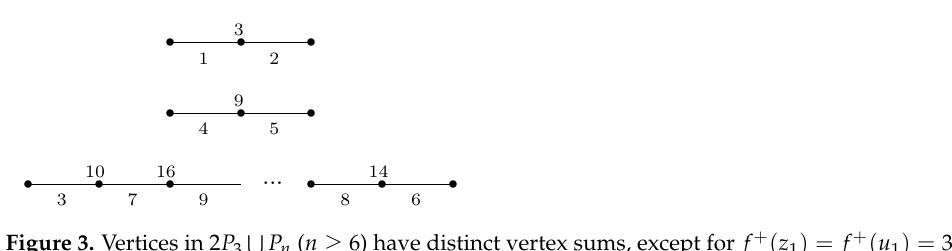
Figure 3. Vertices in 2 P 3